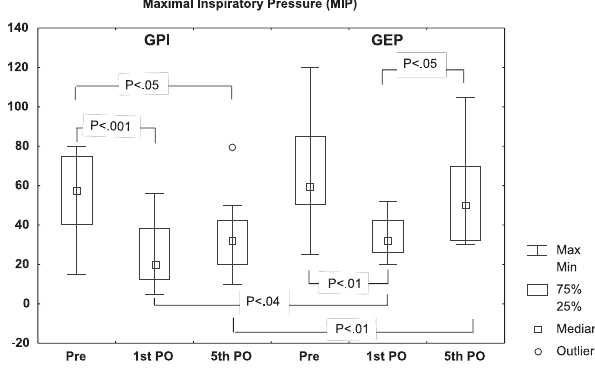
Figure 1 - Maximal inspiratory pressure (MIP) at preoperative (pre), 1st postoperative (1 st PO) and 5 th postoperative (5 th PO) day for the groups studied. (* P <